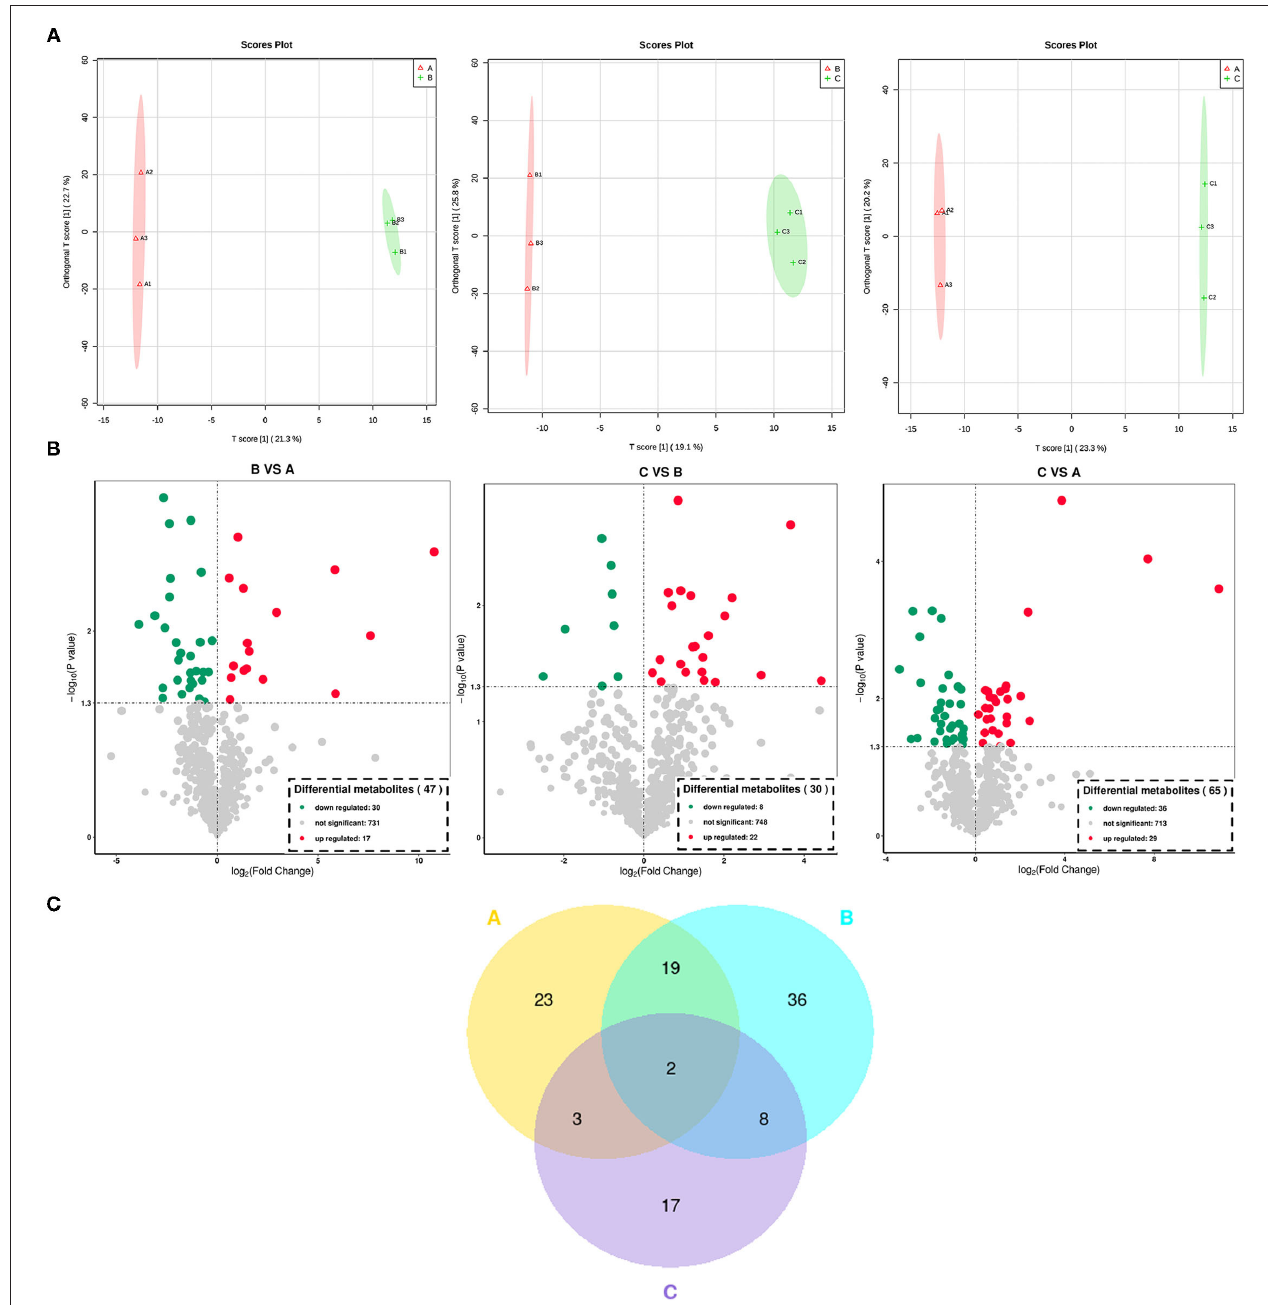
FIGURE 4 | Differential metabolite analysis in all Cistanche deserticola samples processed at different stages. (A) the score plots of the differential metabolites generated from OPLS-DA; (B) the volcano plot of the differential metabolite in different samples; (C) the Veen diagram of the differential metabolite in different samples. A, fresh; B, steamed without drying; C, dried after steaming. OPLS-DA, orthogonal partial least squares discriminant